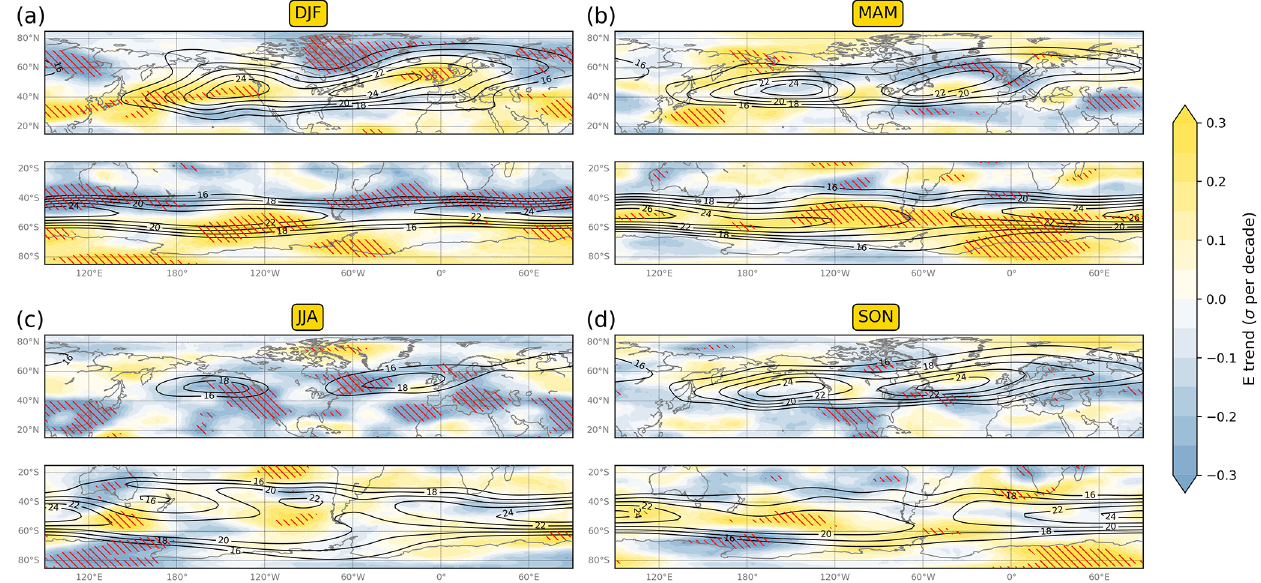
Figure 6. Maps of 1979–2019 linear trends (Theil–Sen estimator; colour shading) in the standardized seasonal-mean E at 300hPa for